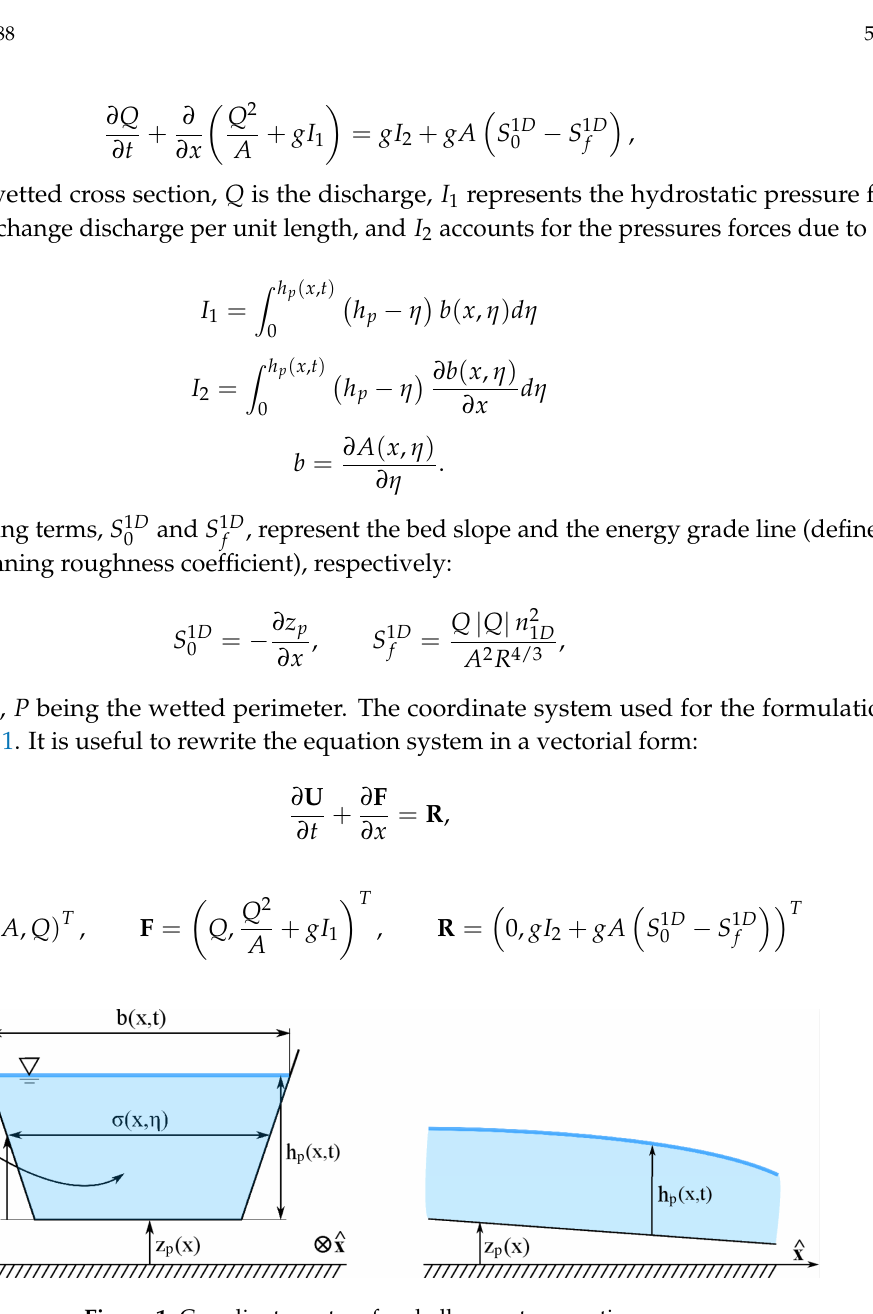
Figure 1. Coordinate system for shallow water